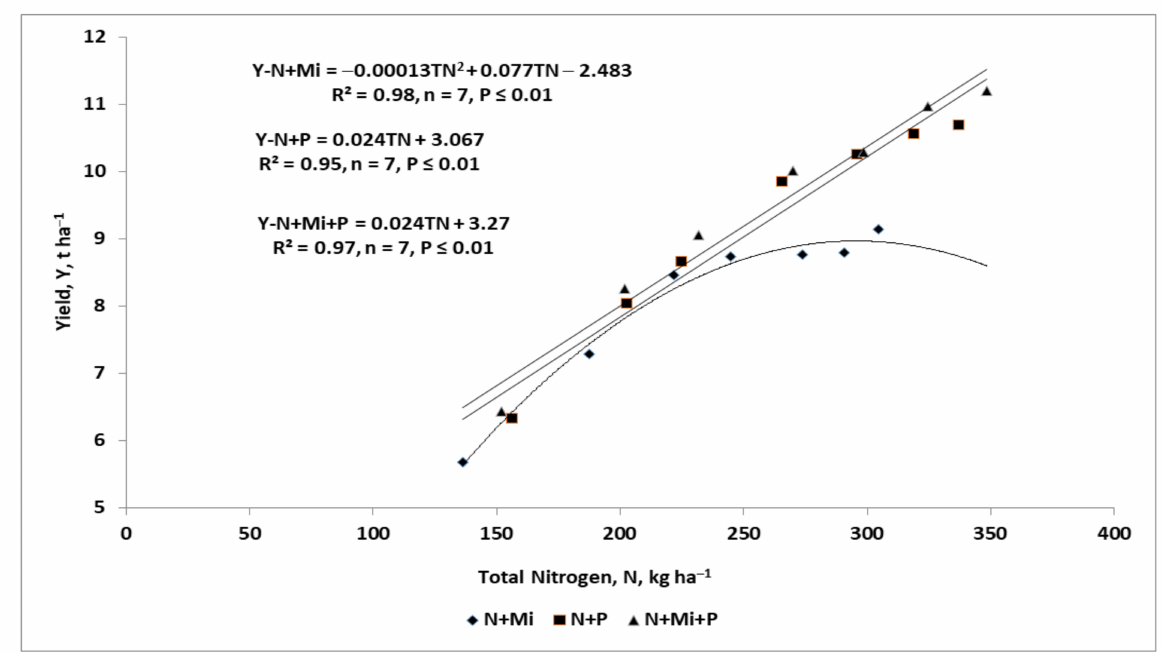
Figure 5. Total nitrogen accumulation by winter wheat in dependence on the system of wheat foliar protection. Legend: N + Mi—N and micronutrients; N + P—N + fungicides; N + Mi + P—N plus micronutrients and